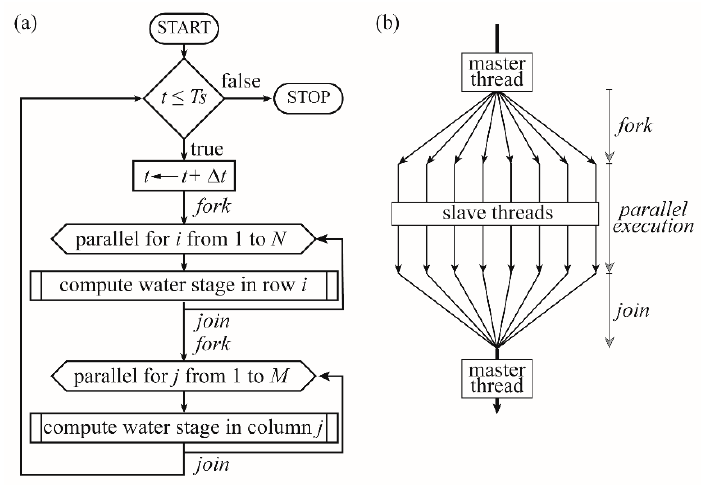
Figure 2. Graph of the main iteration loop in the parallelization process ( a ) and the fork-join model in the OpenMP framework ( b ).